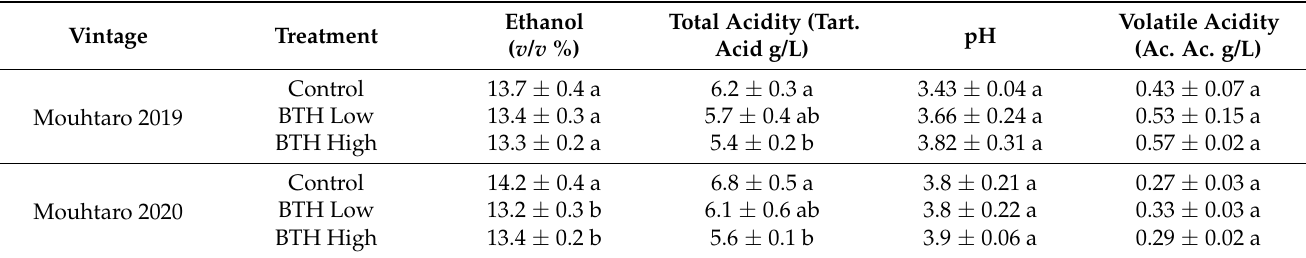
Table 6. Conventional wine analysis parameters of experimental Mouhtaro wines in response to two different BTH treatments (low and high).